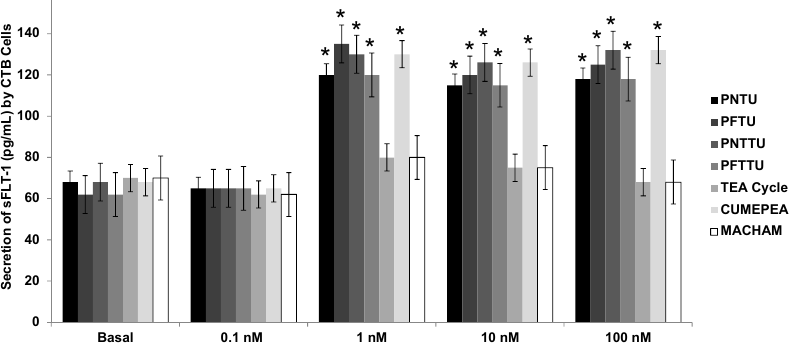
Figure 4. CTB cells were treated with different concentrations of SRs, and the levels of sFlt-1 were measured in the cell culture media by ELISA. The SRs significantly (* p < 0.05) upregulated the secretion of sFlt-1 by CTB cells. The results are presented as the mean ± SEM (n = 6, 4 replicates each).